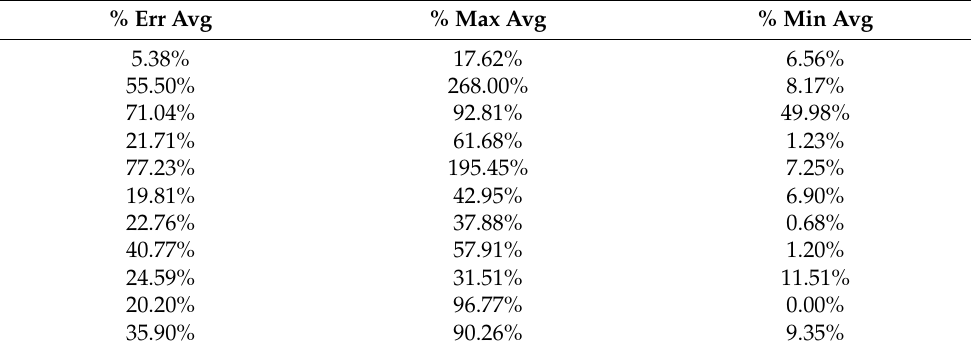
Table A226. Set 3, trials 41–50 data (actual PR value).